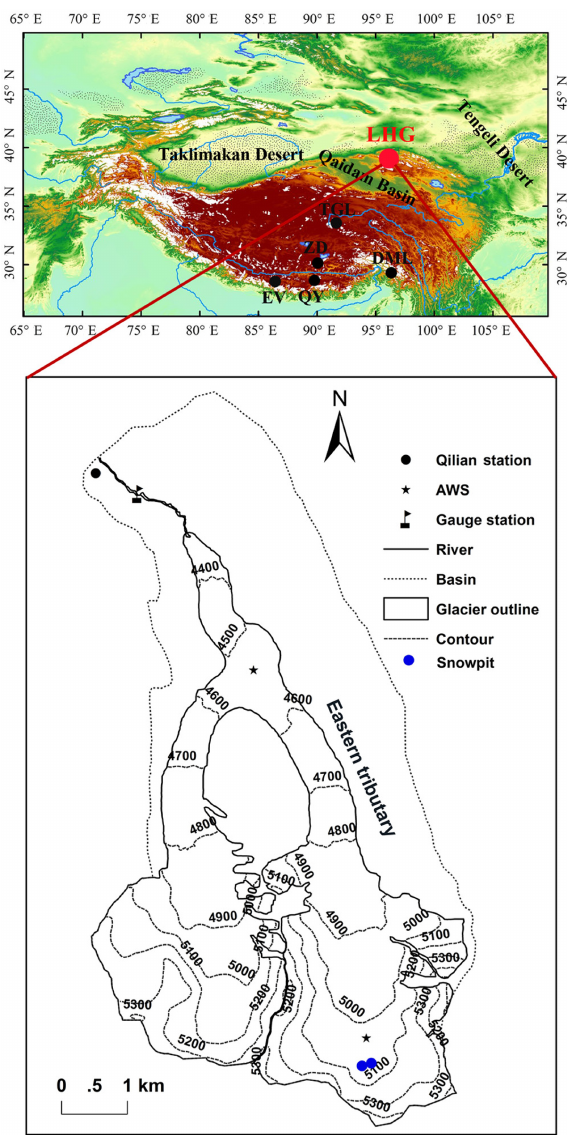
Figure 1. Location map of LHG No.